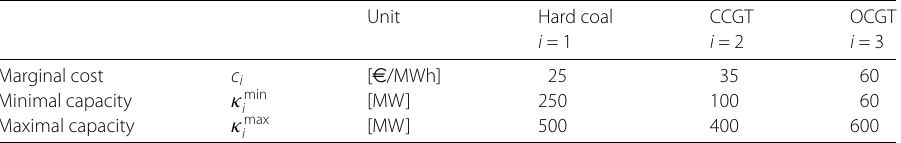
Unit Hard coal CCGT OCGT i = 1